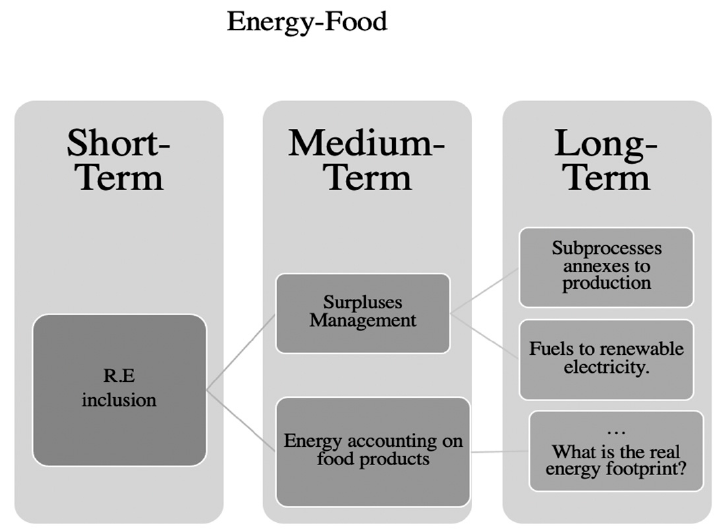
Figure 7. Sustainable environment approach for WEF systems management.